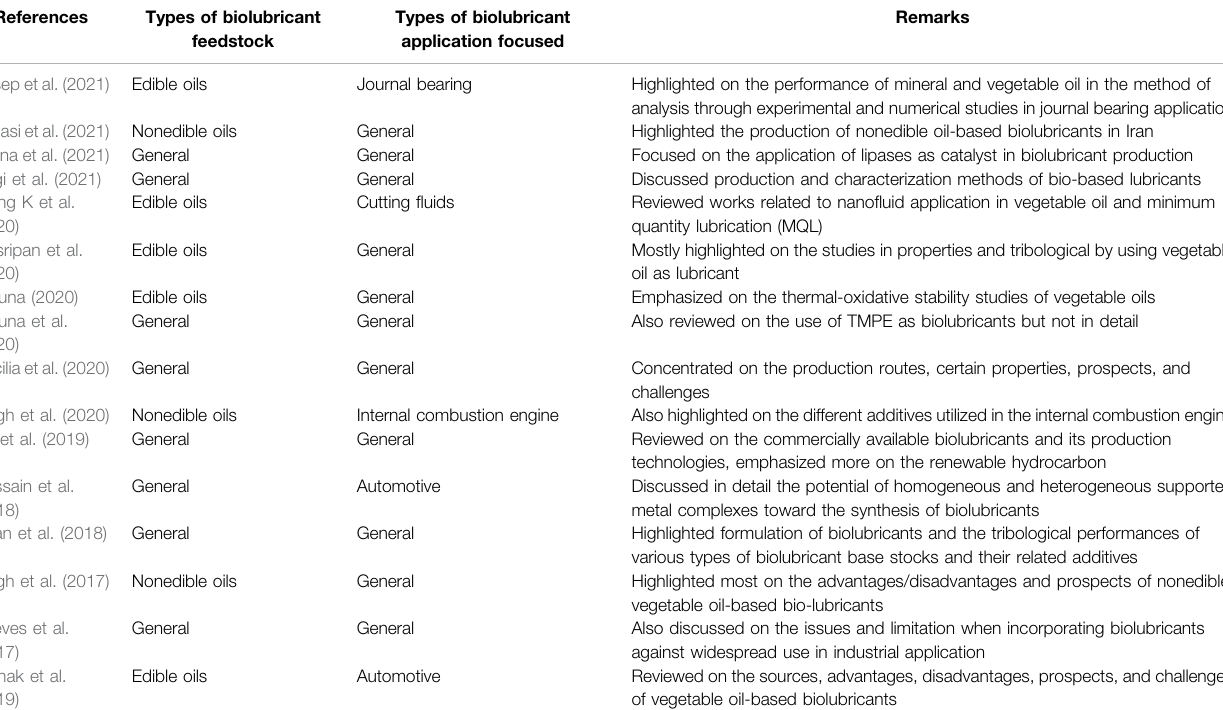
TABLE 1 | Summary of a previous review paper that highlighted the potential of vegetable oil as bio lubricant in general/speci fi c